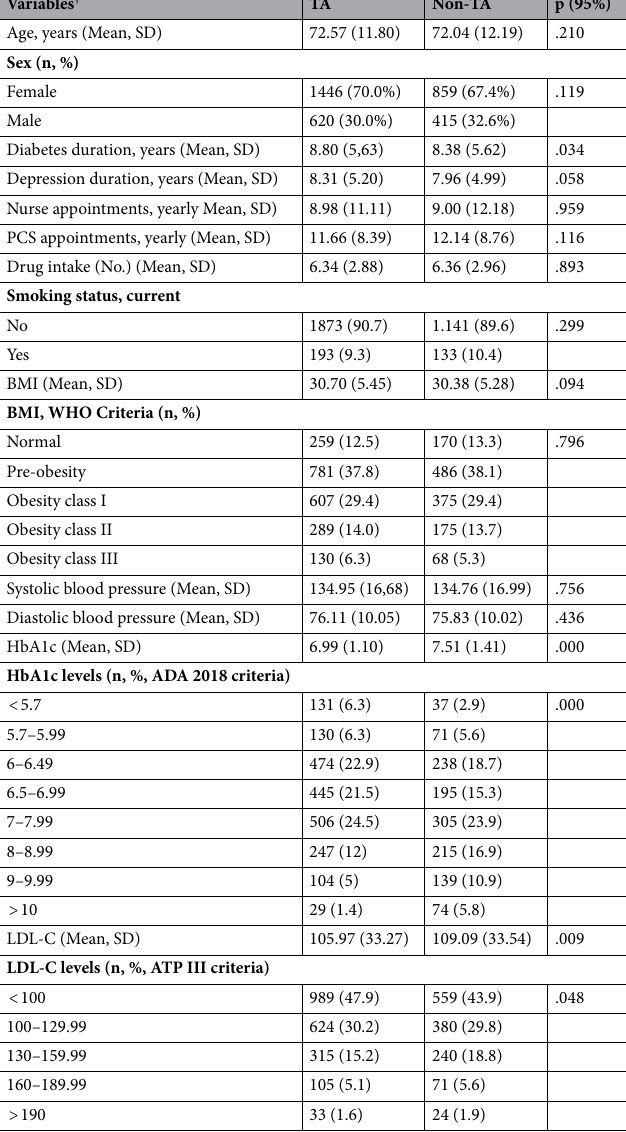
Table 1. Baseline TELE-DD population characteristics of patients with type-2 diabetes and comorbid clinical depression by treatment adherence. † Total N = 3340 for all